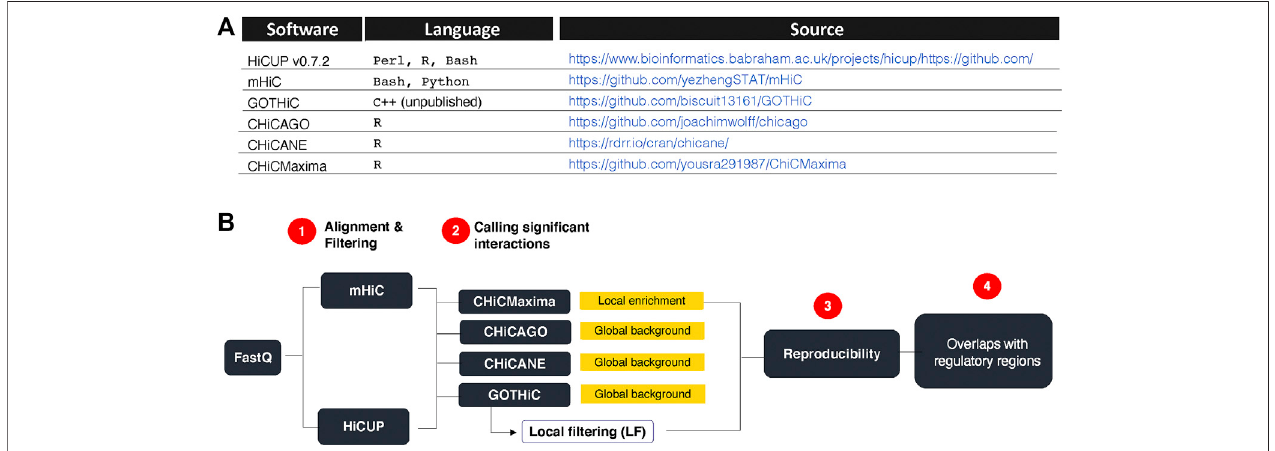
FIGURE1| Researchsummary. (A) .CHi-Canalyticaltoolsusedandtheirsources. (B) .Strategyoverview. HiCUPandmHiCwerecompared fortheirperformance in mapping read pairs and fi ltering experimental artefacts. GOTHiC, CHiCMaxima, CHiCAGO and CHiCANE were compared for their ability to identify reproducible, biologicallyrelevantinteractions.Yellowboxes indicatethetype ofbackgroundmodel usedbyeachtool.GOTHiC local fi ltering(LF) isanoptionaldownstream fi lteringof GOTHiC globally signi fi cant interactions based on the local interaction pro fi le of each bait.